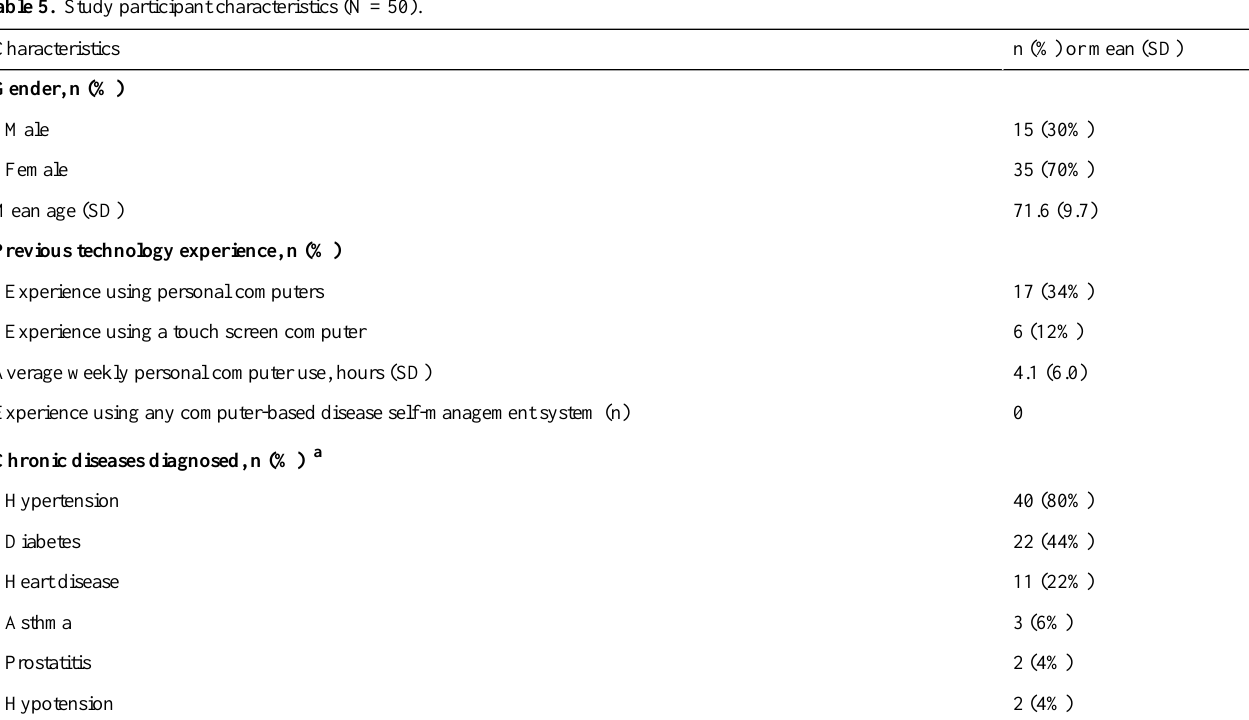
Table 5. Study participant characteristics (N =